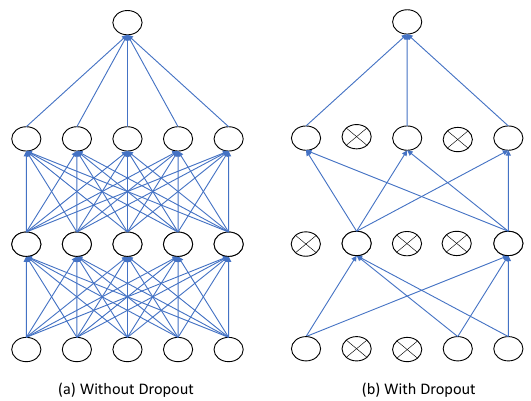
Figure 3. ( a ) A network without dropout and ( b ) a network with